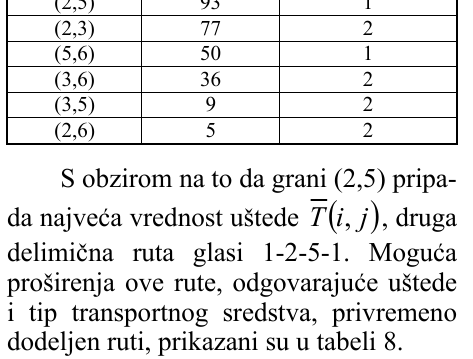
modifikovanog algoritma